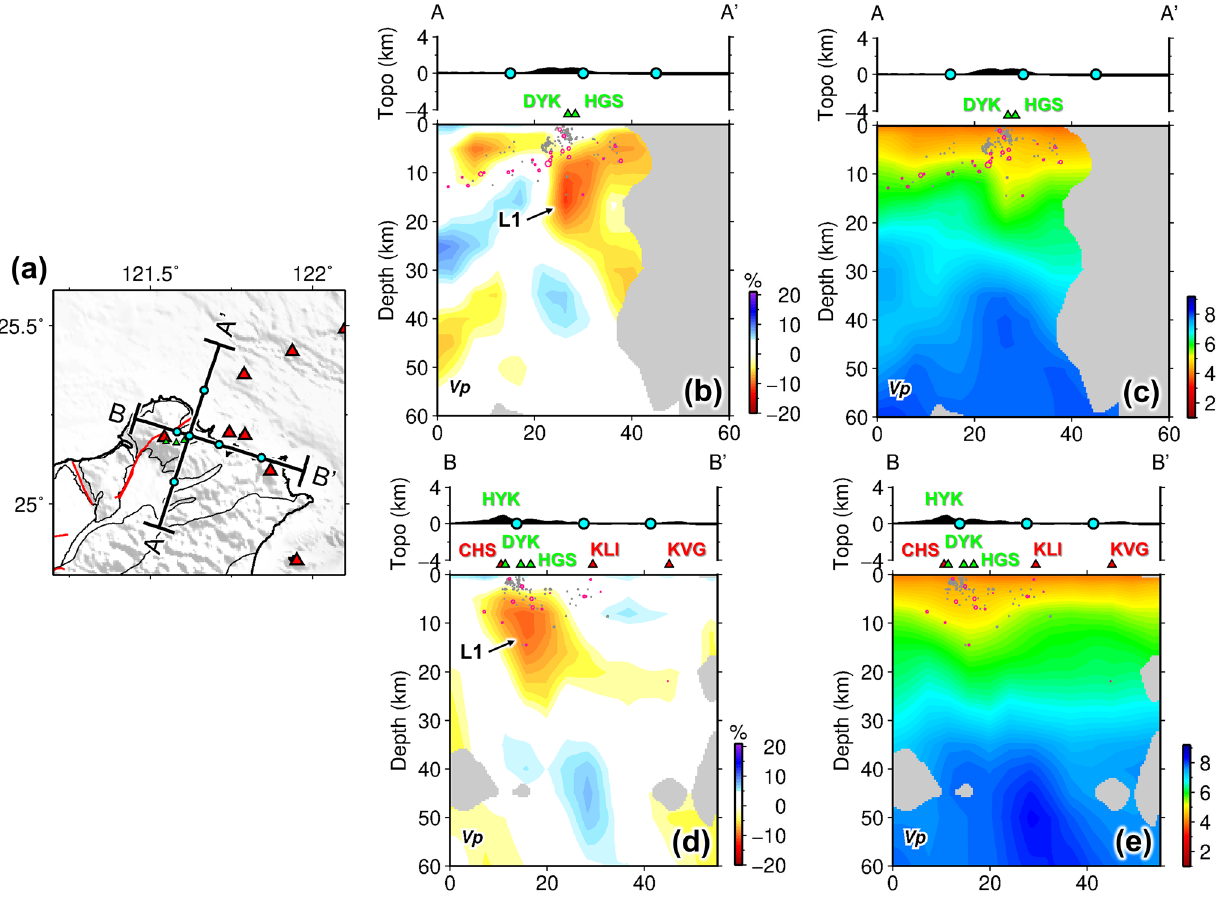
Figure 3. Model results in cross sections across the Tatun volcano group. ( a ) Locations of cross sections AA ′ and BB ′ shown in ( b – e ). Cyan dots mark the distance intervals of cross-sections for reference. P-wave velocity perturbations and absolute values for cross-sections AA ′ and BB ′ are shown in ( b , d ) and ( c , e ) respectively. Red triangles denote the volcano locations of Northern Taiwan volcanic zone. Green triangles are the main fumarole sites and craters in Tatun volcano group. The pink and gray dots denote earthquakes from two different catalogs: the former are the groping events used in the inversion and the latter are local microseismicity determined by TVO seismic network. Labels indicate the velocity anomalies discussed in the text. This figure is generated by GMT 4.5.18 https ://www.gener ic-mappi ng-tools .org/ and Microsoft Office 2016 https ://www.micro soft.com/ zh-tw/micro soft-365/micro soft-offic